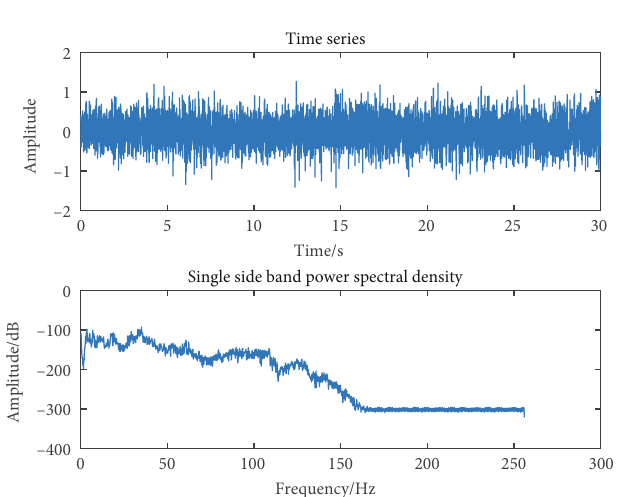
Figure 19: Time series and PSD of the wing in